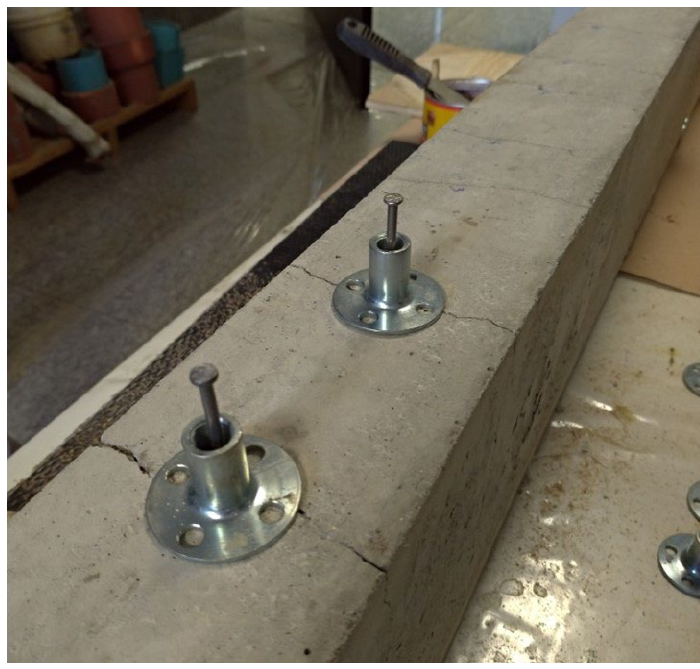
Figure 4. Surface packers secured with nails.